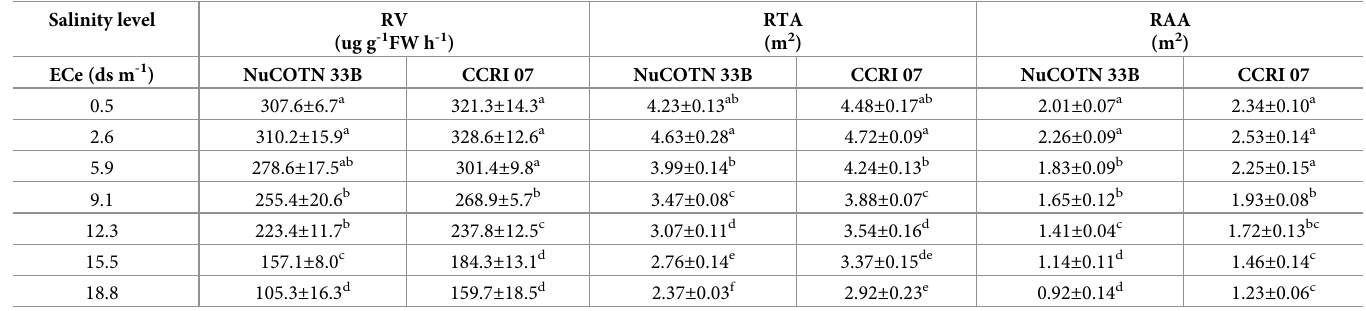
Table 6. Impacts of salinity on root vigor (RV), root total absorption area (RTA) and root active absorption area (RAA) of two Bt cultivars under greenhouse condi- tions in 2017 (n = 4). Different letters represent significant differences in the same column (Duncan multiple range tests, P < 0.05). Salinity